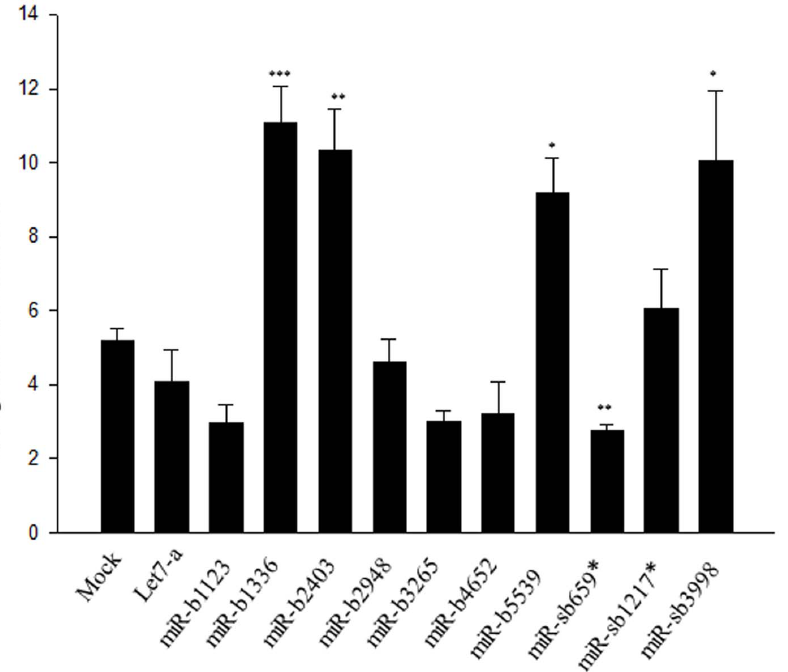
Figure 3. Effect of differentially expressed novel miRNAs on endogenous NEFL steady state mRNA levels in HEK293 T cells. Relative to mock (control), there was no significant change in the NEFL steady state mRNA levels for Let-7a (negative control), mir-b2948 or mir-sb1217*. Increased steady state levels were observed for mir-b1136, b2403, b5539 and sb3998. Reduced steady state levels were observed for mir-b1123, b3265, b4652 and sb659*. Results are shown as mean 6 SEM (t-test: *** =p , 0.001; **=p , 0.005; *=p ,